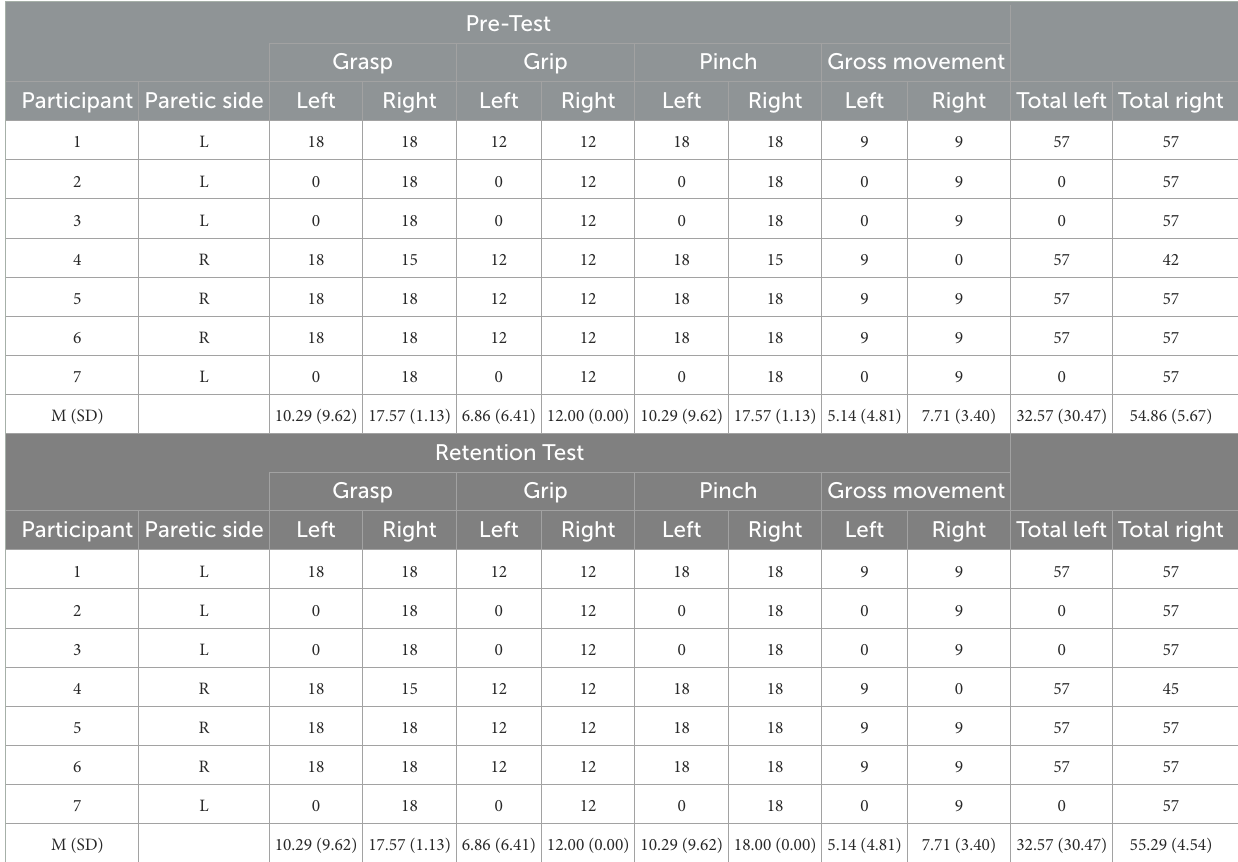
The19itemscomprisingtheARATarescoredusinga4-pointordinalscale,asfollows:0 = nomovement,1 = movementtaskispartiallyperformed,2 = movementtaskiscompletedbuttakes abnormally long, 3 = movement is performed normally. Scores of < 10 points are considered poor, between 10 and 56 points–moderate and 57 points or above correlate with good recovery. Simpson and Eng (110) identified the minimal detectable change (MDC–at 95% confidence level) to be a change in score of 3.5. And van der Lee et al. (111) identified the minimally clinically important difference (MCID) in a defined chronic stroke population to be 10% of the total range of the measure (i.e., 5.7 points) and 12–17 points for a defined acute stroke population. None